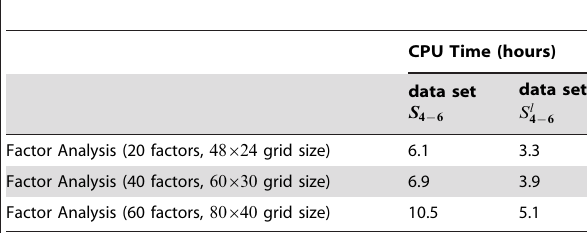
Table 4. Representative relative CPU times of the